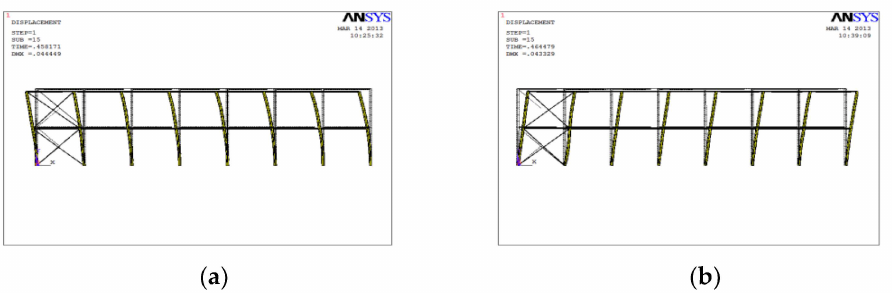
Figure 5. Instability modes of column-braced systems under horizontal and vertical loads. ( a ) The horizontal loads to the left; ( b ) The horizontal loads to the